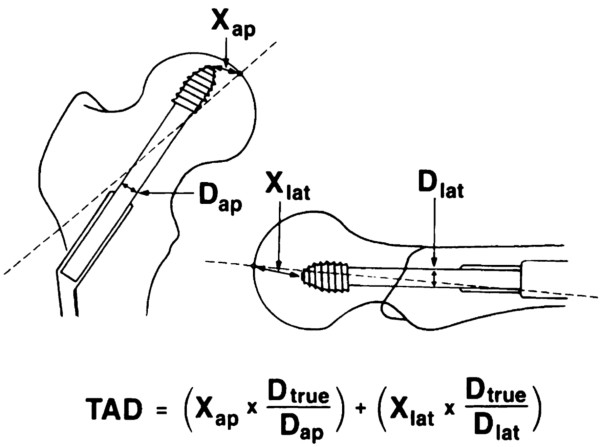
Measurement of the TAD[20].